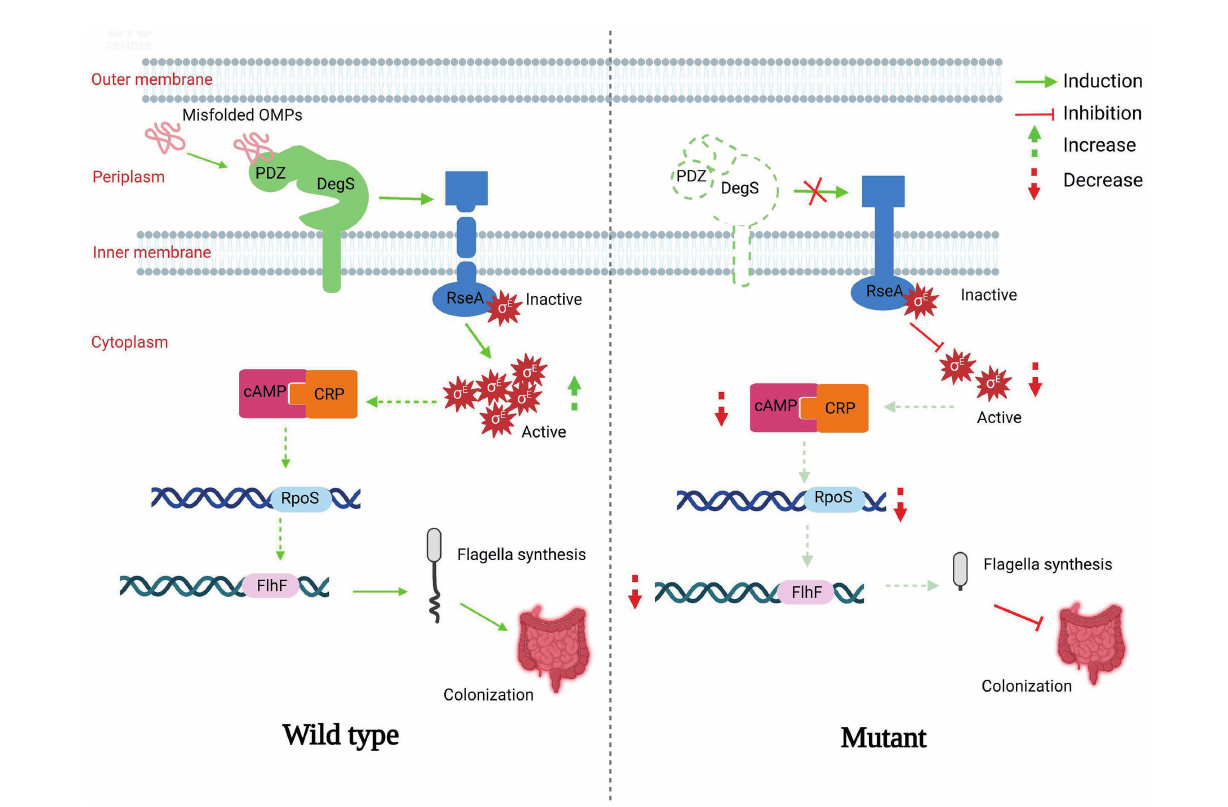
FIGURE 6 A proposed model showing the mechanisms whereby DegS positively regulates Vibrio cholerae motility. In the normal state (wild type), the PDZ domain of DegS binds to a large number of misfolded outer membrane proteins and promotes RseA cleavage to release active σ E . Subsequently, the expression of flhF is induced via the cAMP–CRP–RpoS signaling pathway, resulting in the synthesis of bacterial flagella. In the degS knockout state (mutant), RseA cleavage is suppressed, amounts of σ E and cAMP–CRP complex are reduced, and the transcription of rpoS and flhF is downregulated, resulting in impaired bacterial flagella development and poor colonization ability. A red arrow represents inhibition and a downward-pointing dashed red arrow represents a reduction. A green arrow represents induction and an upward-pointing green dashed arrow represents an